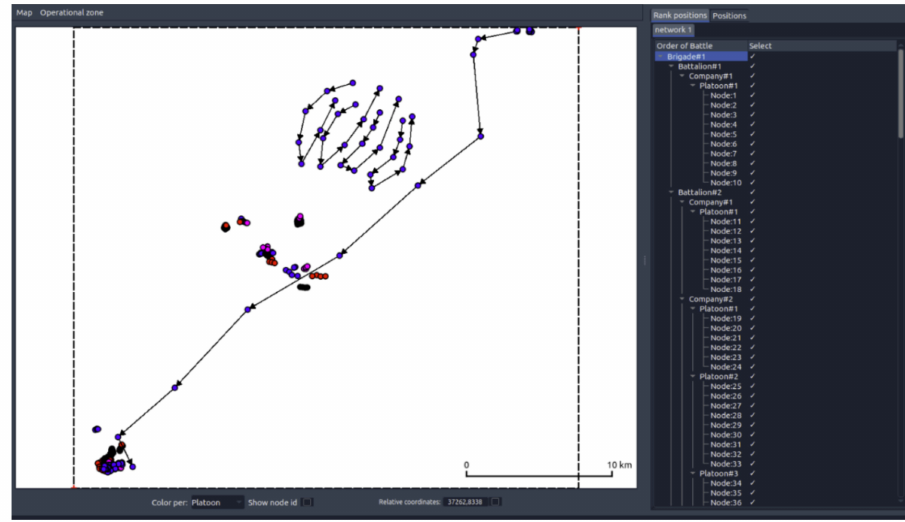
Figure 13. Position and trajectory for